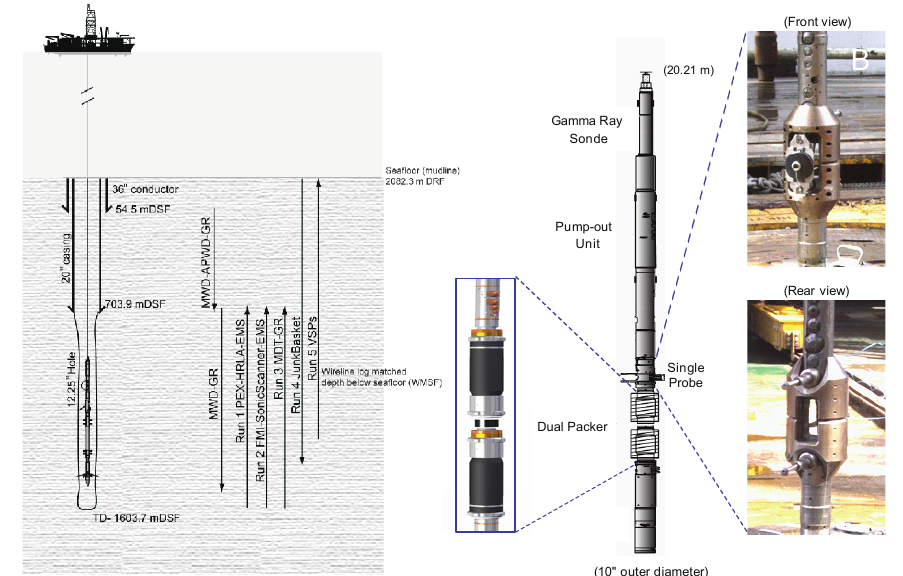
Figure 2. Modular formation dynamic tester (MDT) tool in operation and illustration of all logging runs from Expedition 319. Measurement- Figure 1. Modular Formation Dynamics Tester (MDT) in operation and illustration of all logging runs from while-drilling to total-depth was followed by five runs of wireline Expedition 319. Measurement While Drilling to total-depth was followed by five runs of wireline toolstrings.